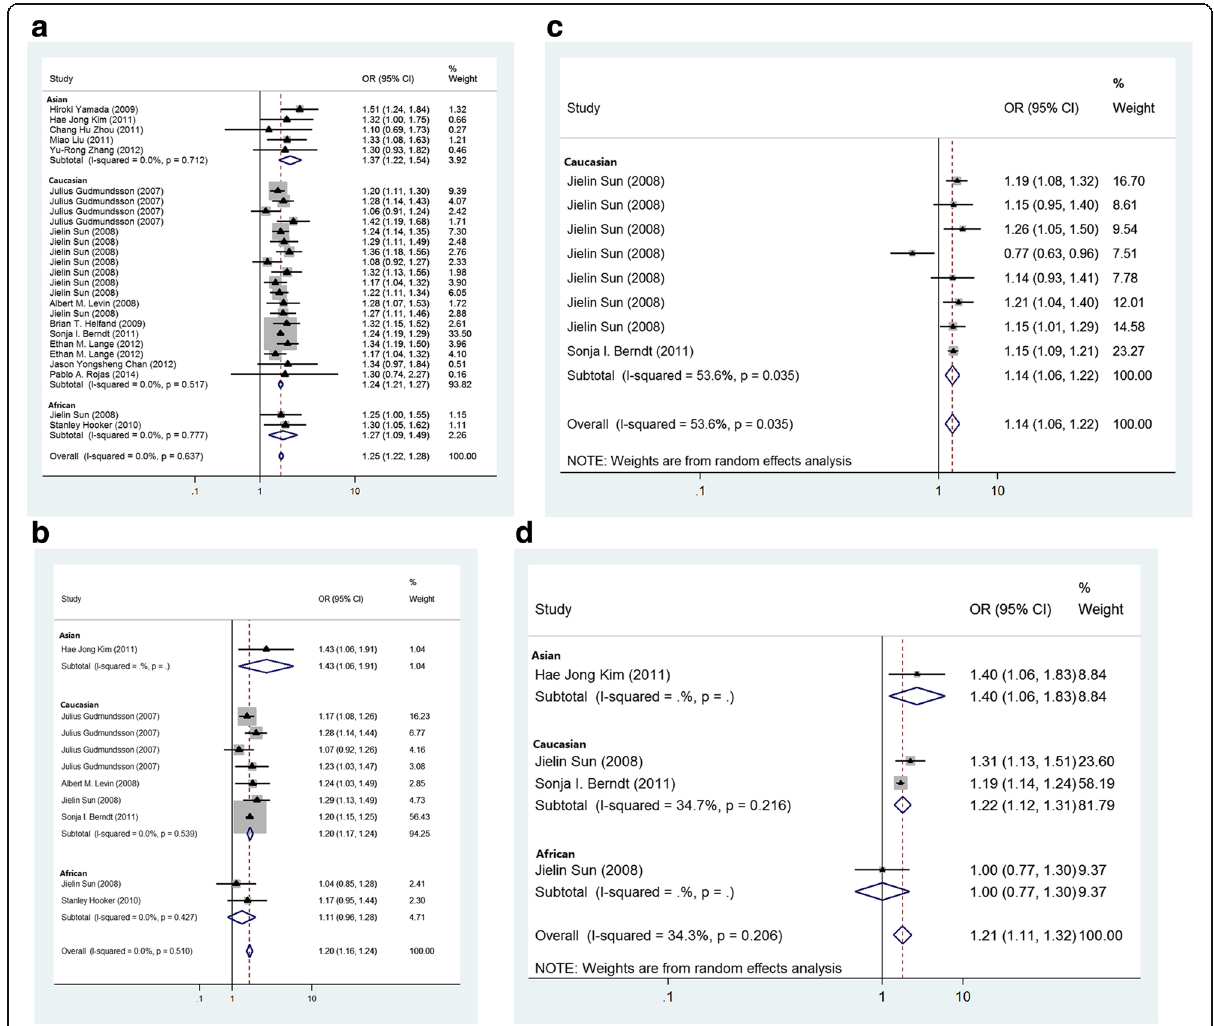
Fig. 2 a Fixed-effects meta-analysis of allele (A versus G) of the HNF1B rs4430796 G > A and prostate cancer. The OR of each study is represented by a square, and the size of the square represents the weight of each study with respect to the overall estimate. 95% CIs are represented by the horizontal lines, and the diamond represents the overall estimate and its 95% CI. b . Fixed-effects meta-analysis of allele (G versus A) of the HNF1B gene rs7501939 A>G and prostate cancer. c . Radom-effects meta-analysis of allele (G versus A) of the HNF1B gene rs11649743 A>G and prostate cancer. d . Fixed-effects meta-analysis of allele (C versus A) of the HNF1B gene rs3760511 A>C and prostate